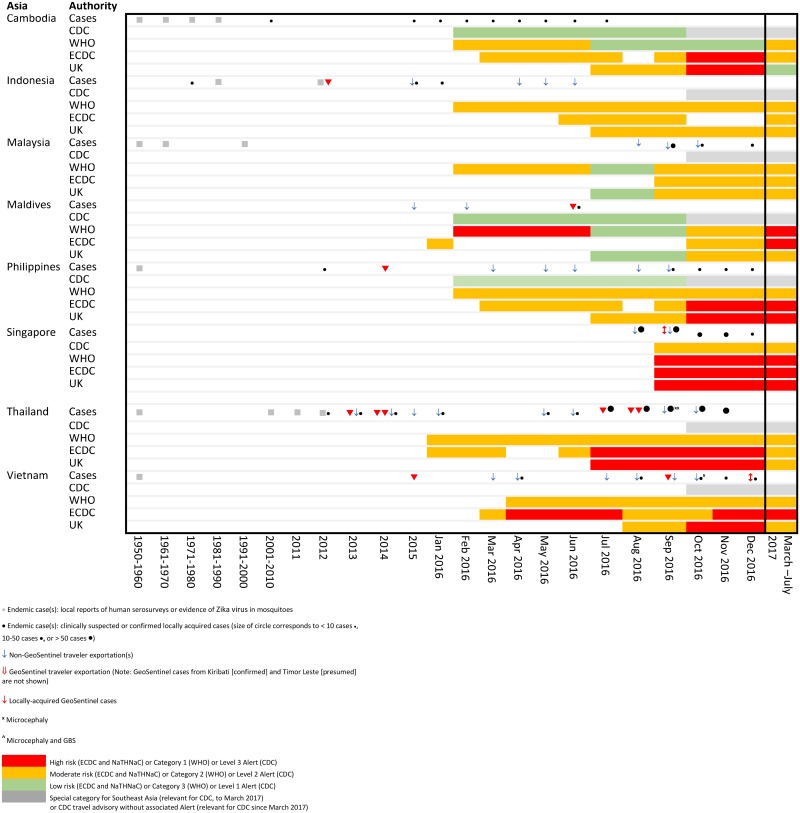
Temporal association of endemic and exported cases with travel notices by international authorities for selected countries in Asia.